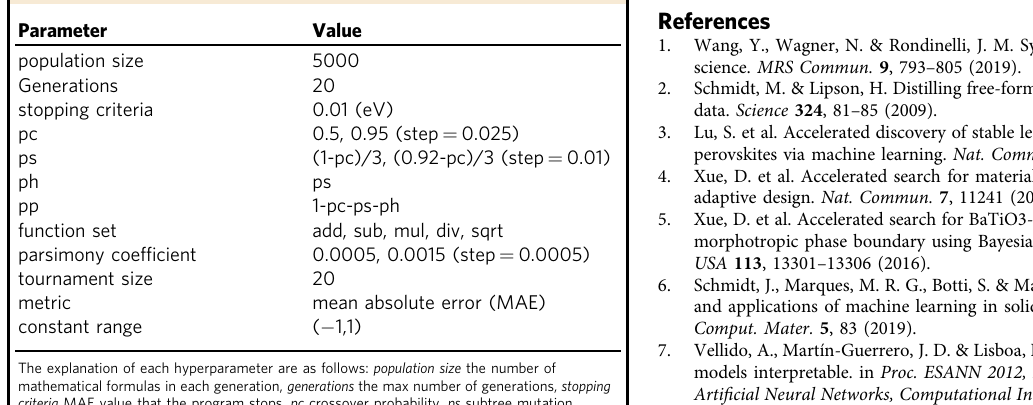
Table 3 The setup of hyper-parameters in gplearn for GPSR.